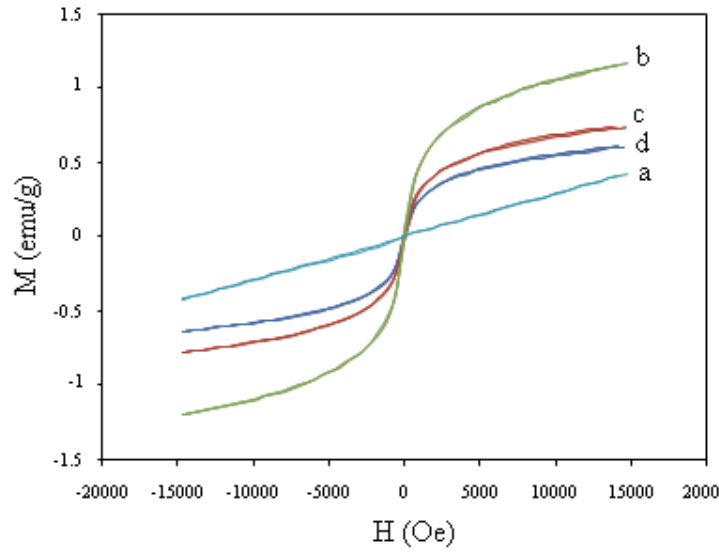
Figure 6. Magnetization curve at room temperature for zinc ferrite nanoparticles with concentration of (a) 0, (b) 15, (c) 40, and (d) 55 g/L, which calcined at 873 K.